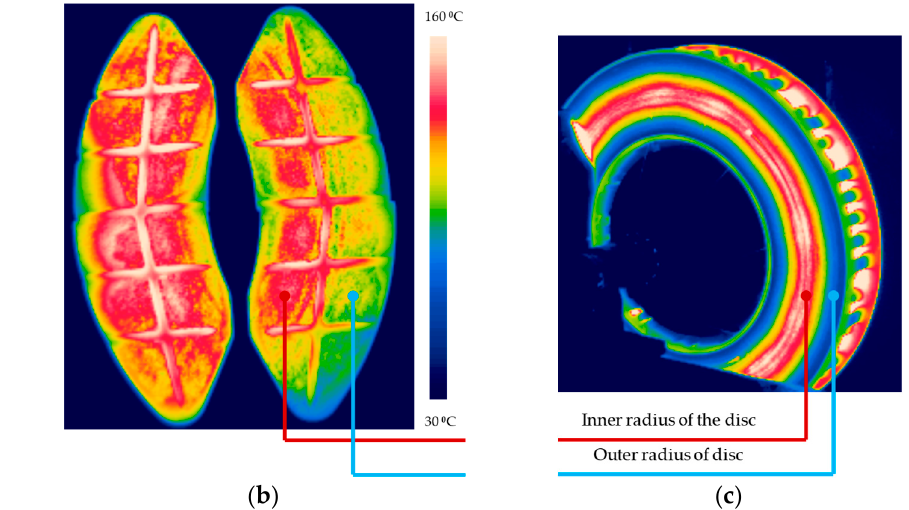
Figure 10. View of the friction pair after testing: ( a ) friction pad view, ( b ) friction pad thermal image, ( c ) brake disc thermal image after braking from v = 200 km/h. The thermal imaging tests proved that, in all friction elements, the pad temperature is not the same. The maximum temperature in one of the pad areas was 146.8 ◦ C on the upper left friction pad, while the lowest pad-to-disc contact temperature was 111.3 ◦ C on the lower right pad. In the paper [56], the issue of uneven distribution of pad pressures relative to the disc was explained by the uneven weight distribution of the right and left sides of the brake lever system as well as by the change in geometric dimensions of the brake lever during braking and gradual wear of the pads. The thermal imaging tests showed that the non-uniform temperature distribution on the right brake pads in terms of the inner and outer braking radius affected the variable temperature distribution on the right side of the brake disc. In Figure 10c, it was possible to observe a hot band on the inner radius with the beginning of the formation of hot spots type areas after one braking from 200